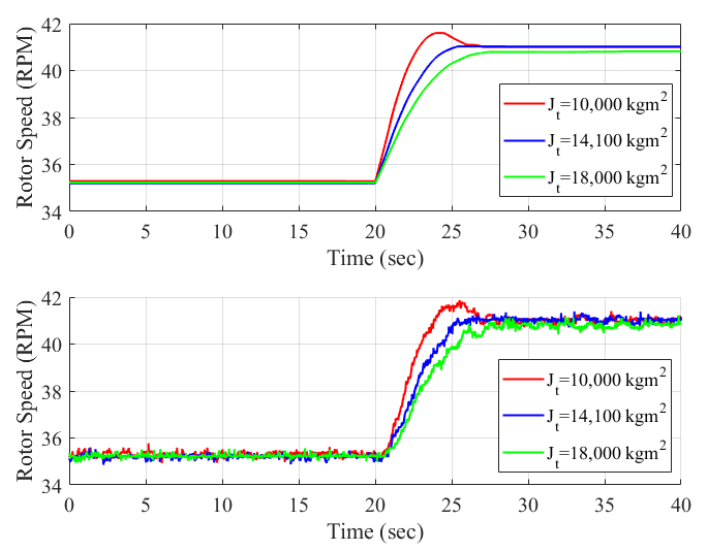
Figure 10. Effect of rotor inertia on the rotor speed ( Top : HIL simulated rotor speed; Bottom : Measured rotor